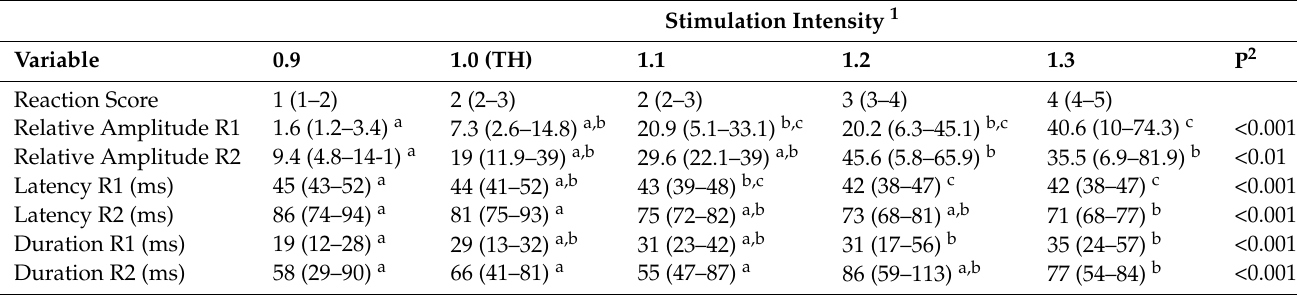
Table 2. Median (interquartile range) values obtained during electromyographic recordings of the right deltoid muscle in 12 horses stimulated over the right lateral palmar digital nerve with 25-ms train-of-5 constant-current pulses (duration 1 ms) delivered by a computer-controlled stimulator at various stimulation intensities: 0.9, 1.0, 1.1, 1.2 and 1.3 times the nociceptive withdrawal reflex (NWR) threshold (TH).